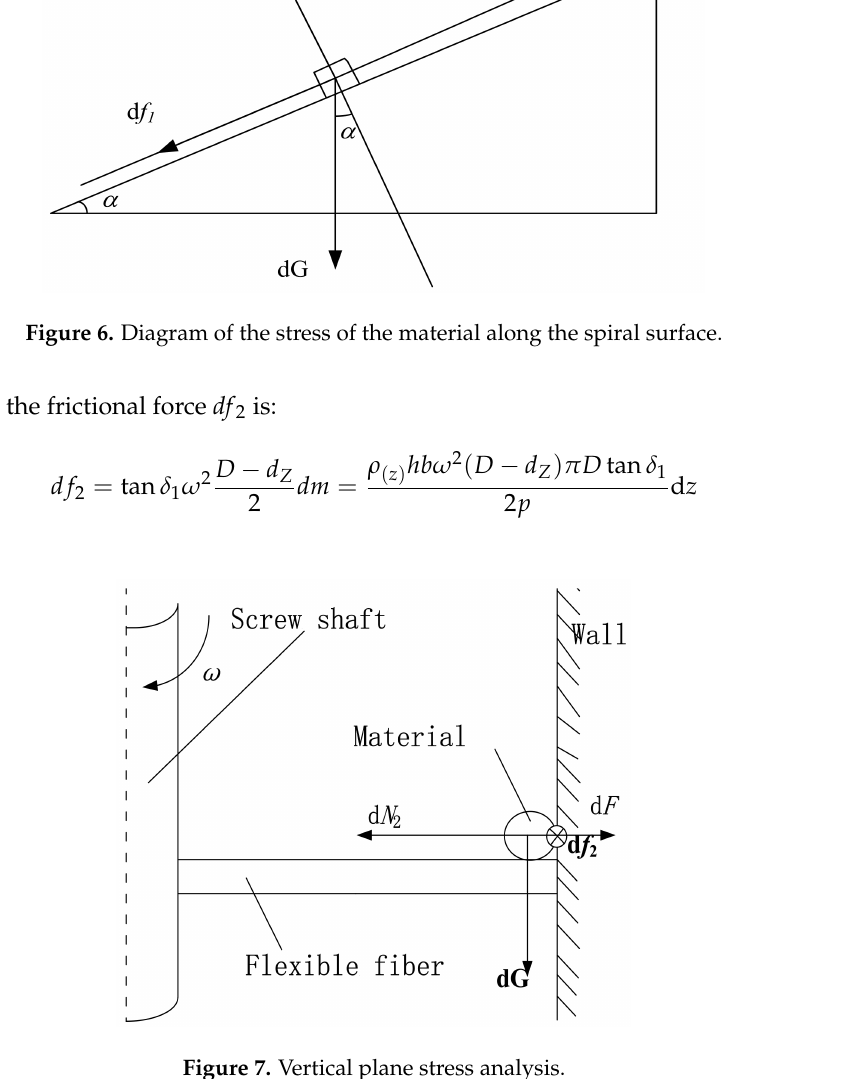
Figure 7. Vertical plane stress